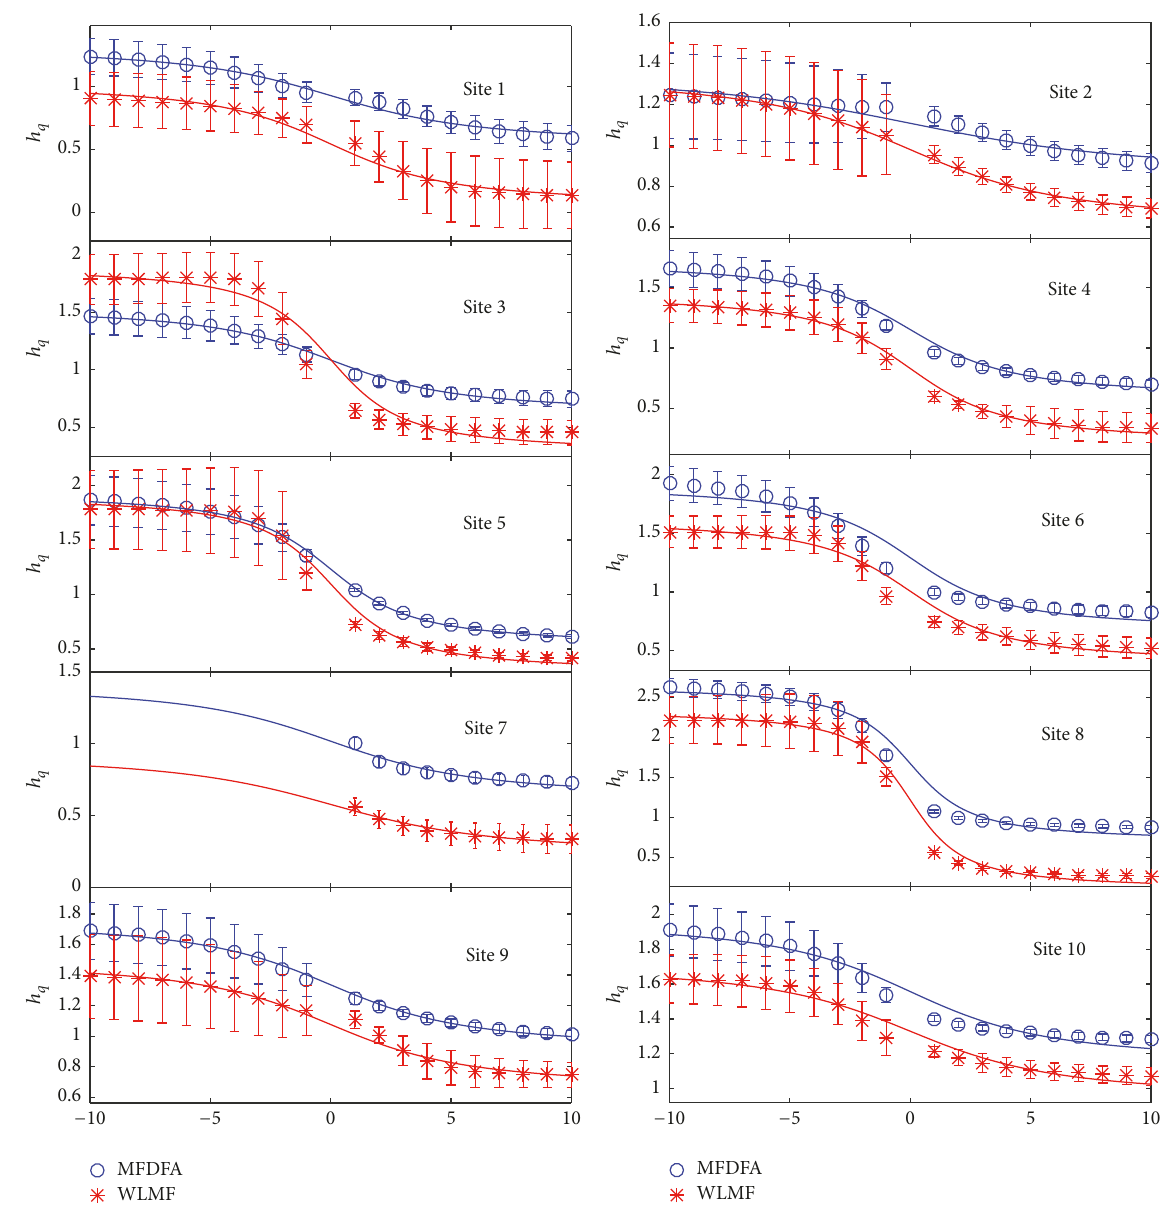
Figure 8: Comparison of the shape of ℎ(𝑞) assessed by MF-DFA and WLMF. The curves are obtained by fits of the two-parameter binomial model, yielding (16). The different colors indicate the corresponding different fitting results. The resulting model parameters are reported in Table 8. These results correspond to an averaging over 100 sets of daily records. The errors bars are obtained from these sets and reveal 95% confidence